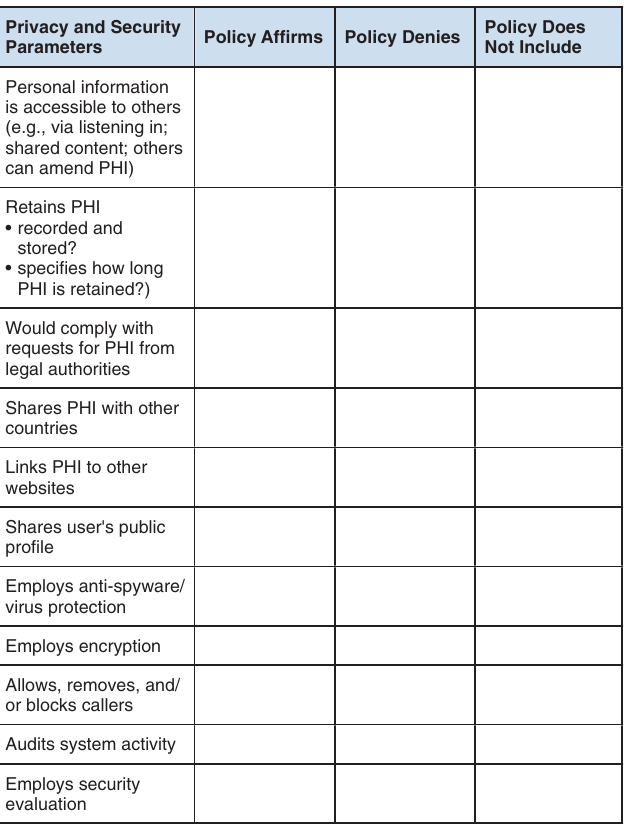
Table 1: Checklist for privacy and security information provided by consumer-based, free VoIP